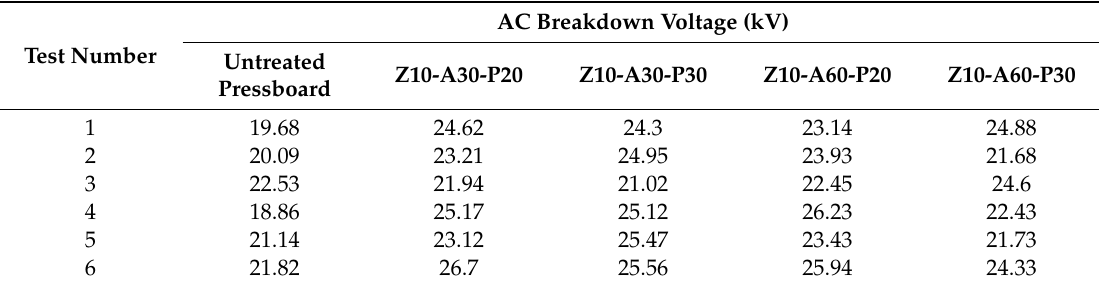
Table 2. AC breakdown voltage of the untreated and modified insulating pressboards.